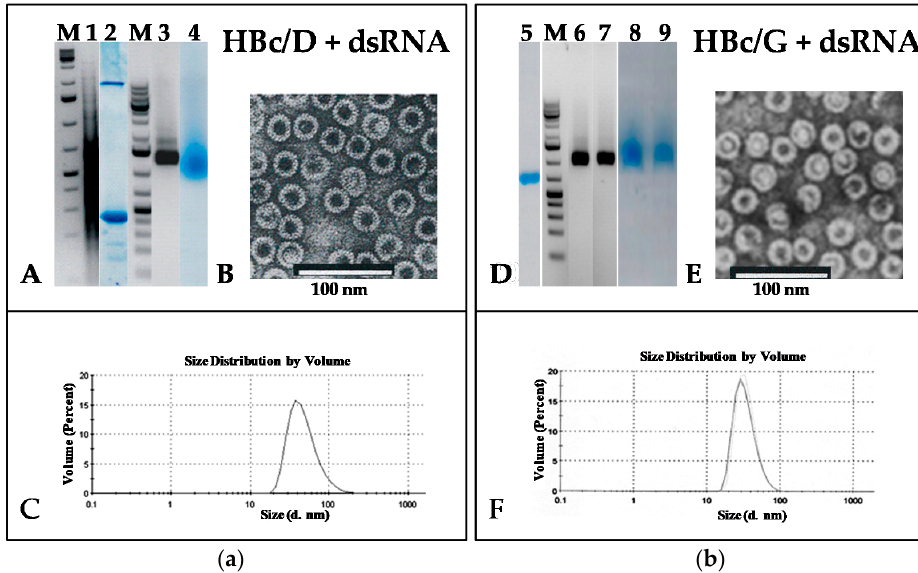
Figure 6. Analysis of HBc/D ( a ) and HBc/G ( b ) VLPs packaged with phage f2sus11 dsRNA. ( a ) A , M —NAGE in 2% agarose of GeneRuller 1 kb DNA Ladder (SM1331, Thermo Scientific™, Vilnius, Lithuania) and 1 —of f2sus11 dsRNA; 2 —SDS-PAGE of the Superdex 200 peak fraction containing VLPs packaged with dsRNA, stained with Coomassie Brilliant Blue R-250; 3 , 4 —NAGE of the same Superdex 200 fraction: 3 —stained with EtBr, and 4 —stained with Coomassie Brilliant Blue R-250 . B , electron microscopy of HBc/D VLPs packaged with dsRNA. C , DLS of HBc/D VLPs packaged with dsRNA. ( b ) D , 5 —SDS-PAGE of HBc/G VLPs packaged with dsRNA; M —NAGE of GeneRuller 1